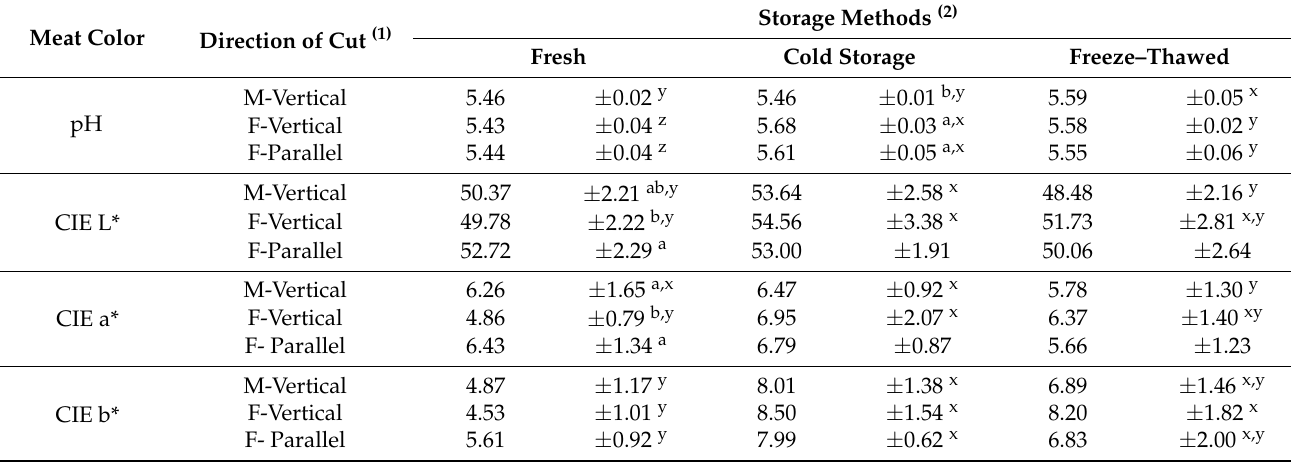
Table 2. Comparison of pH and meat color of pork loin chops cut in different